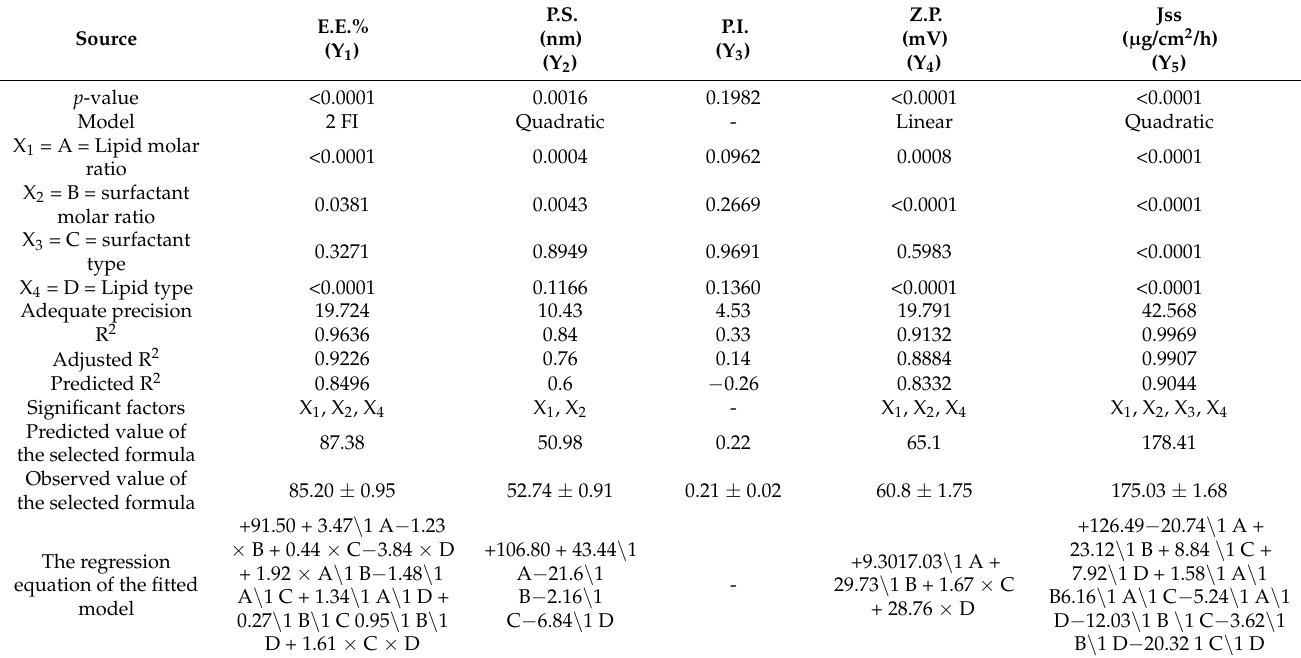
Table 3. Output data of the DOD analysis of LPX formulations and predicted and observed values for the selected LPX